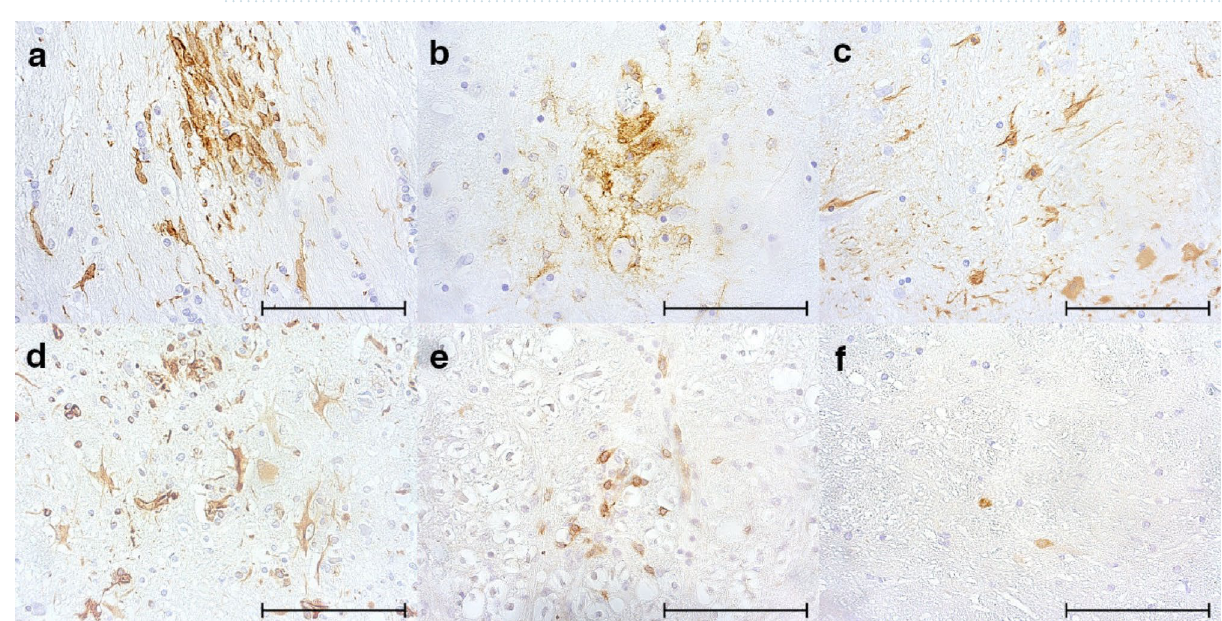
Figure 4. Phenotyping of cellular responses in the brain of infected foxes ( a ) Iba1 + microglia/macrophages, cerebrum. ( b ) MHC II expressing antigen-presenting cells, cerebrum. ( c ) GFAP + astrocytes, cerebrum. ( d ) vimentin + immature astrocytes, cerebrum. ( e ) CD3 + T cells, brainstem. ( f ) Pax5 + B cells, cerebrum. ( a )–( f ) immunohistochemistry, scale bars = 100